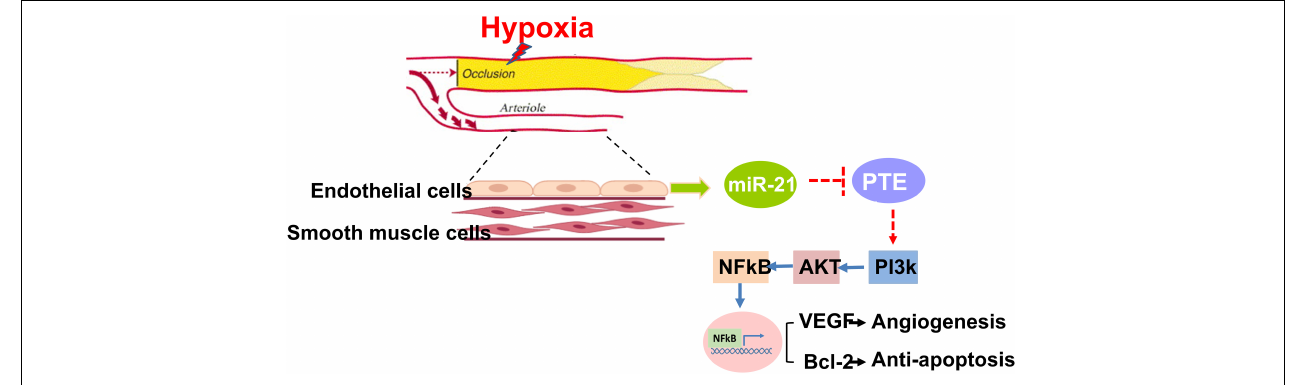
FIGURE 7 | Summary of miR-21 in augmenting hypoxia-triggered angiogenesis and attenuating apoptosis in the process of limb